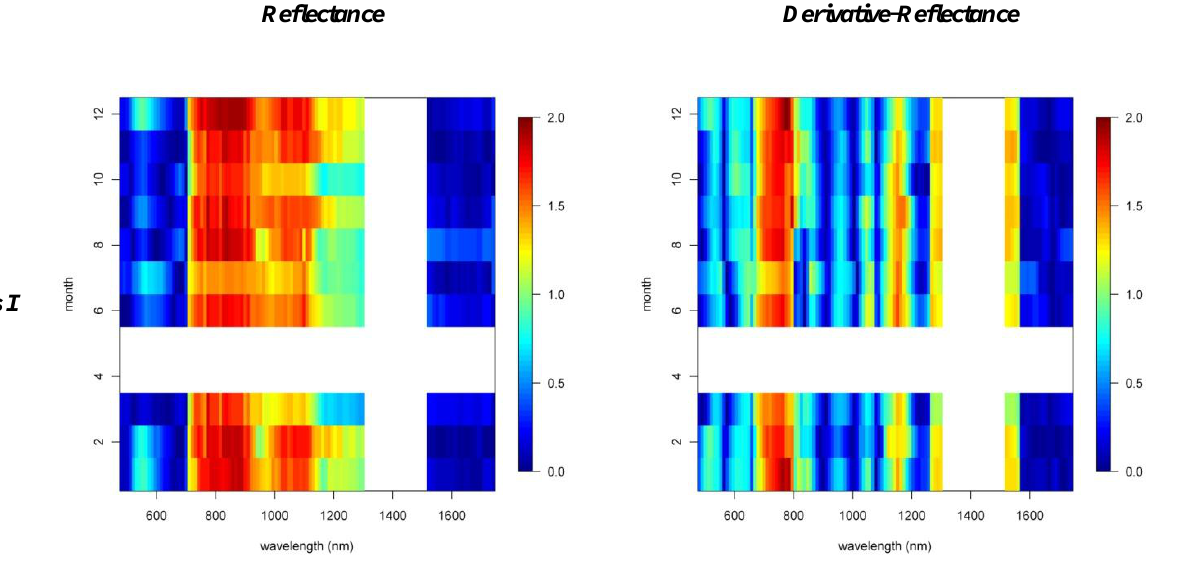
Figure 2. Reflectance and 1st-d reflectance spectro-temporal Separability Index charts for the pairwise species comparisons. Reflectance